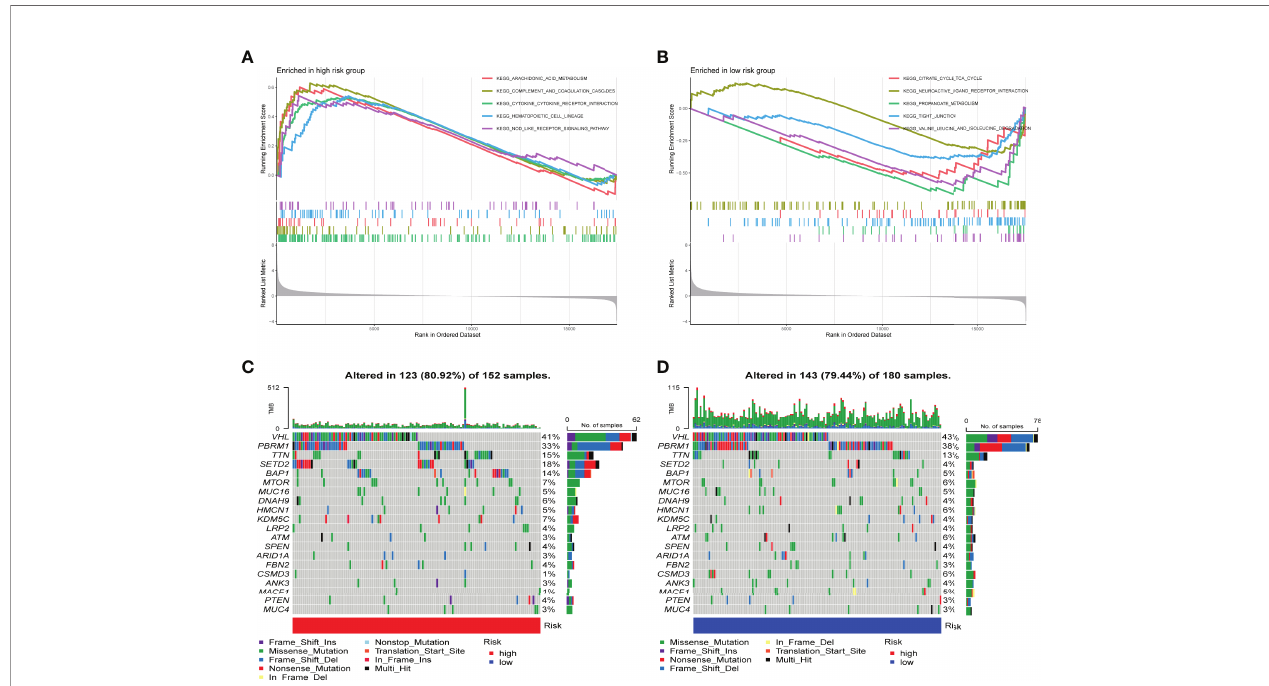
FIGURE 5 | Molecular characterization of different subgroups of IRPDGs. (A) GSEA of the high-risk subgroup of IRPDGs. (B) GSEA of the low-risk subgroup of IRPDGs. (C) Signi fi cant gene mutations in the high-risk subgroup of IRPDGs. (D) Signi fi cant gene mutations in the low-risk subgroup of IRPDGs. The percentage of mutations is shown vertically on the right and the total number of mutations is shown above. The color-coding indicates the mutation